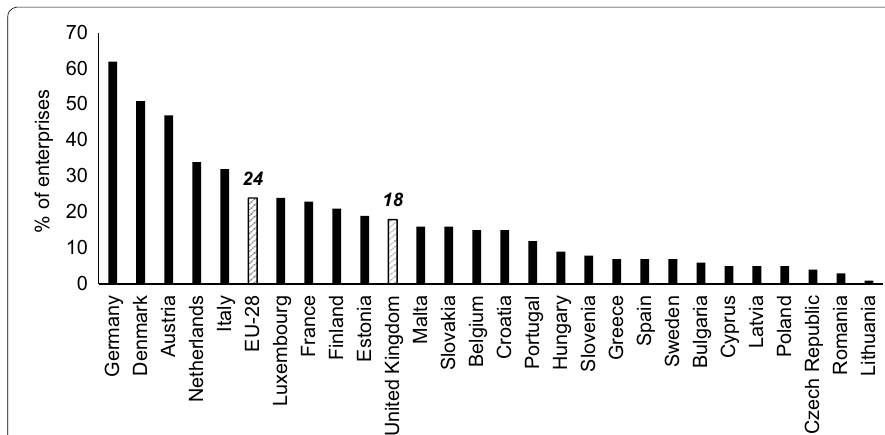
Fig. 2 Percentage of employers providing initial vocational education and training (IVET) to employees, EU, 2010 (Source: Continuing Vocational Education and Training Survey 2010)